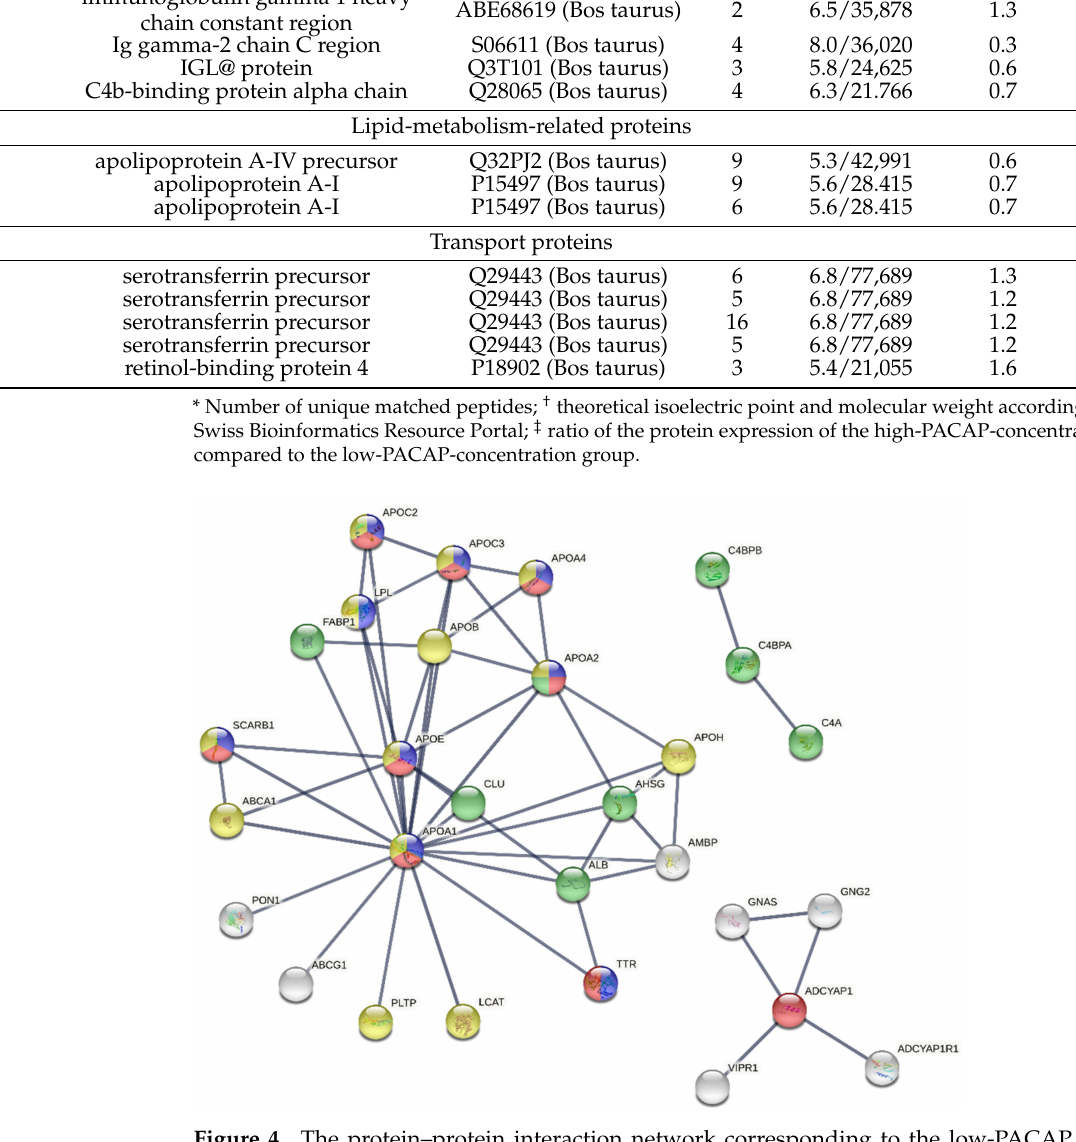
Figure 4. The protein–protein interaction network corresponding to the low-PACAP (pituitary adenylate cyclase-activating polypeptide)-concentration group. Colour indicates proteins take part in lipid metabolic process (blue), transport (red), response to stress (green) and cholesterol metabolism (yellow). White colour indicates the second shell of interactors. Our input: ADCYAP1: pituitary adenylate cyclase-activating polypeptide; APOA1: apolipoprotein A-I; APOA4: apolipoprotein A-IV; C4BPA: C4b-binding protein alpha